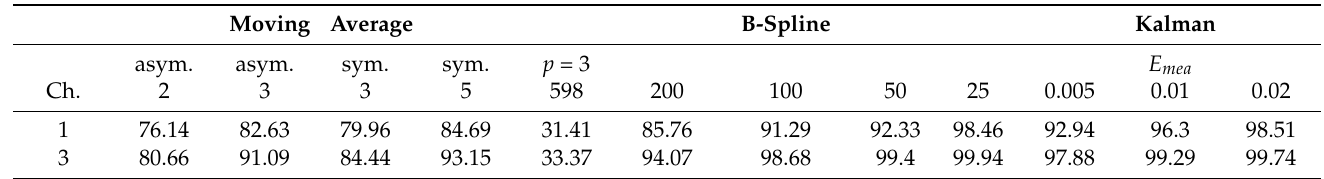
Table 7. The percentage of difference of the SM2 performance metric (100 × (SM20 − SM21)/SM20) for moving average, B-spline, and Kalman filters for signals from channels 1 and 3 of the root-joint for the kicking model using various control